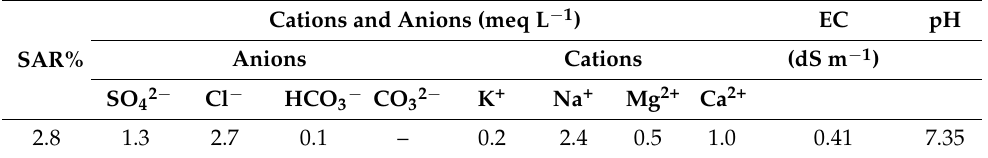
Table 4. Chemical characteristics of irrigation water